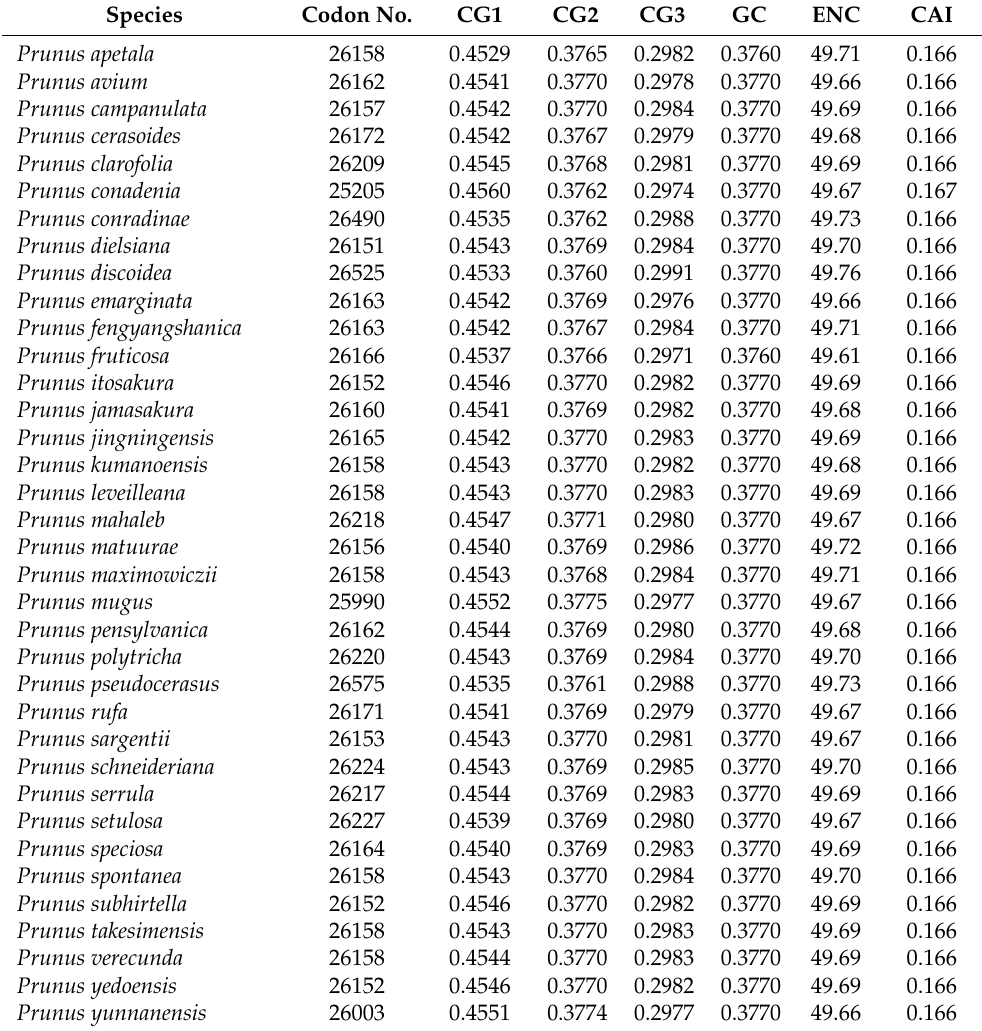
Table 1. Codon features of 36 subg. Cerasus chloroplast